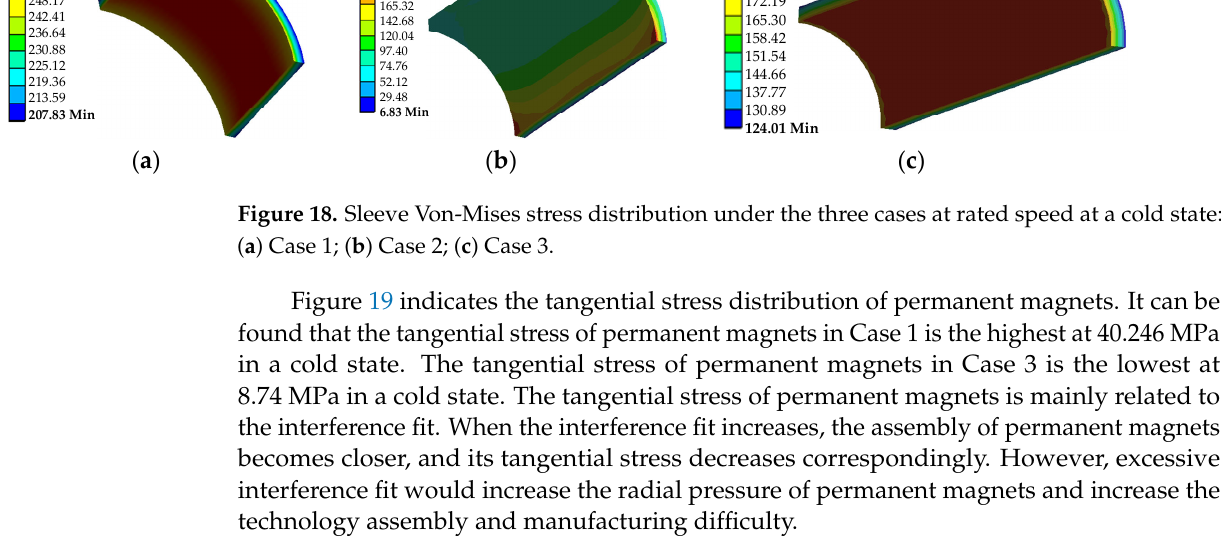
Figure 18. Sleeve Von ‐ Mises stress distribution under the three cases at rated speed at a cold state: ( a ) Case 1; ( b ) Case 2; ( c ) Case 3.